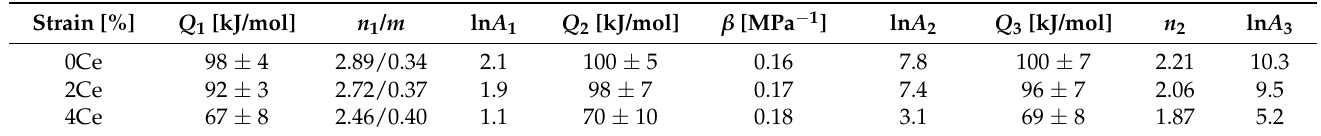
Table 3. The material parameters and the effective activation energy of the superplastic deformation values for the Equation (4) calculated for a true strain of 0.41